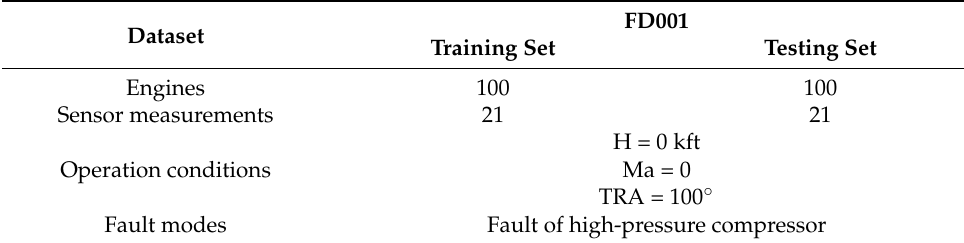
Table 8. FD001 data description.